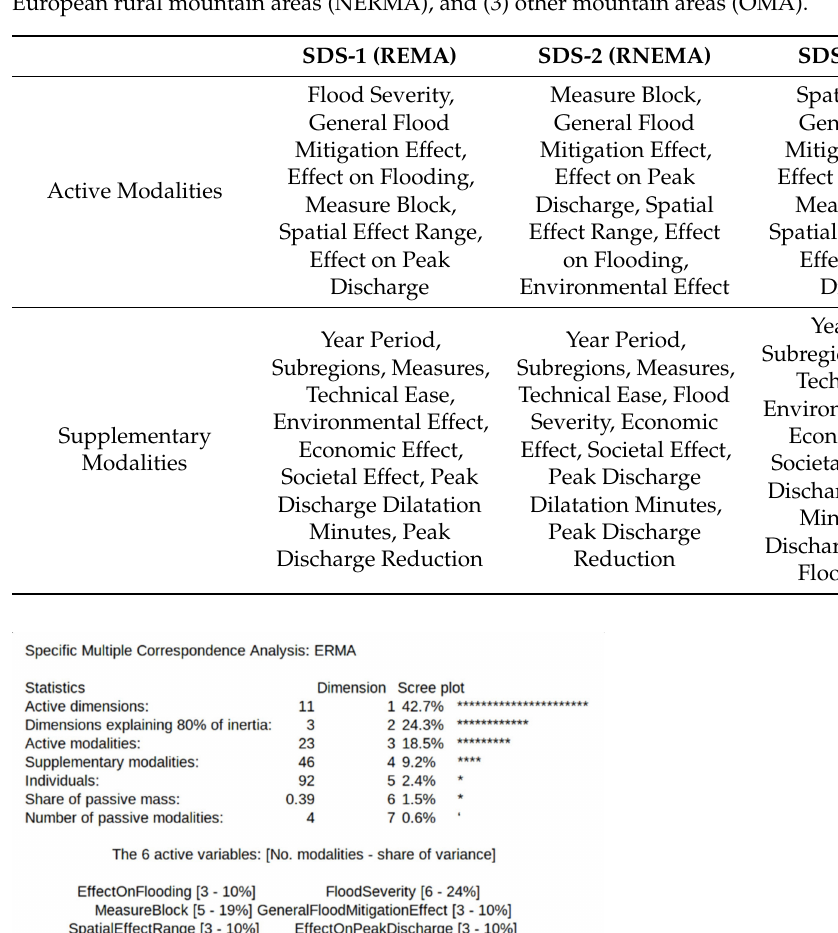
Table A2. Final configuration of models used in the analysis of the literature data, in other words, sub-data sets (SDS) for flood management in (1) European rural mountain areas (ERMA), (2) non- European rural mountain areas (NERMA), and (3) other mountain areas (OMA).